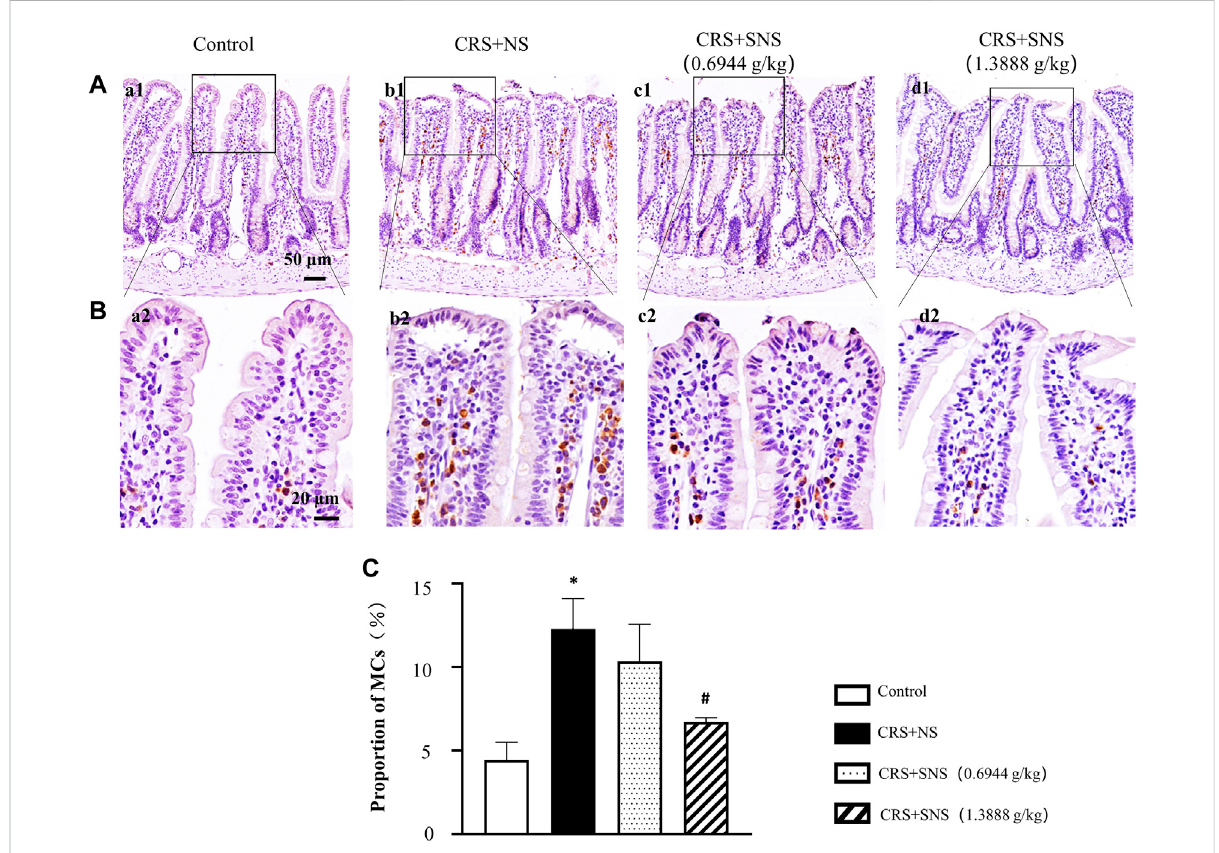
FIGURE 11 Effect of the SNS treatment on the number of MCs of ileum. (A) Representative low magni fi cation of immunohistochemical staining images of the anti-tryptase antibody in ileum tissues in the Control (a1), CRS + NS (b1), CRS + SNS(0.6944 g/kg) (c1), CRS + SNS (1.3888 g/kg) (d1) groups, respectively. Bar = 50 μ m. (B) Representative high magni fi cation of immunohistochemical staining images of the anti-tryptase antibody in ileum tissues intheControl(a2), CRS +NS(b2), CRS +SNS(0.6944 g/kg) (c2), CRS + SNS(1.3888 g/kg)(d2) groups, respectively. Bar =20 μ m. (C) The countsofMCsintheileumtissuesoftheratsineachgroup.F=12.82. p =0.0020.Resultsarepresentedasmean±SEM.* p < 0.05vs.Controlgroup; # p < 0.05 vs. CRS + NS group. (A – C) n =